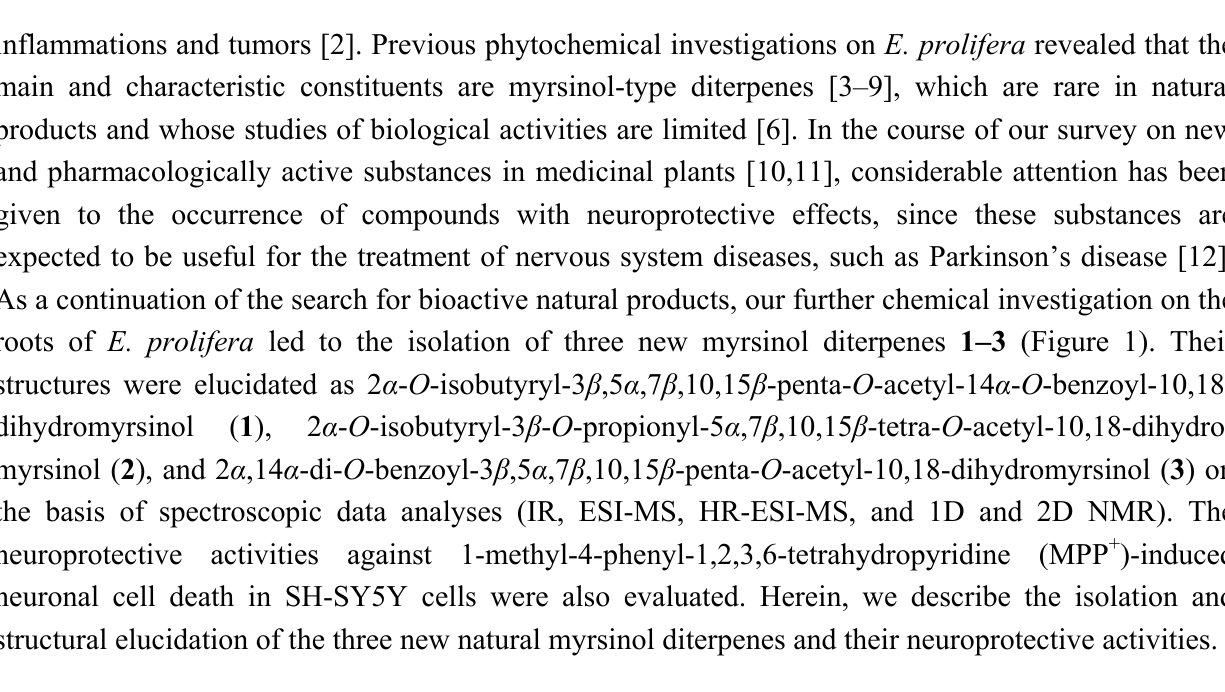
Figure 1. Structures of compounds 1 – 3 from E.